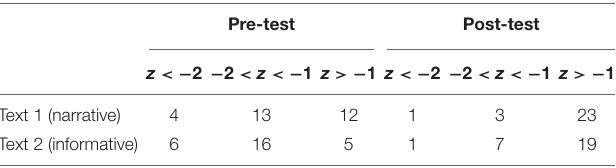
TABLE 3 | Changes in performance in relations to norms (provided by the manual) after the training program Cloze.